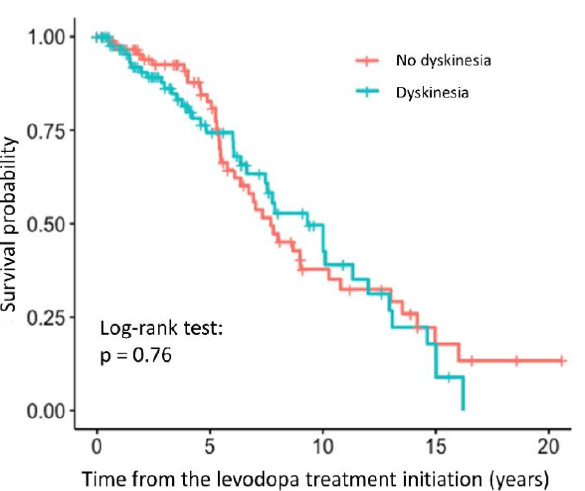
Figure 4. Survival curve for PD patients with and without dyskinesia after levodopa treatment